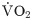
The rate of change for tissue oxygenation index (TOI; Panel A), deoxygenated hemoglobin ([HHb]; Panel B), and total hemoglobin ([Hb]total; Panel C) as a function of oxygen uptake (V˙O2).Note that the absolute change in TOI and [HHb] as a function of the increase V˙O2 during exercise were significantly less in cancer survivors compared to controls. Values are mean ± SE.